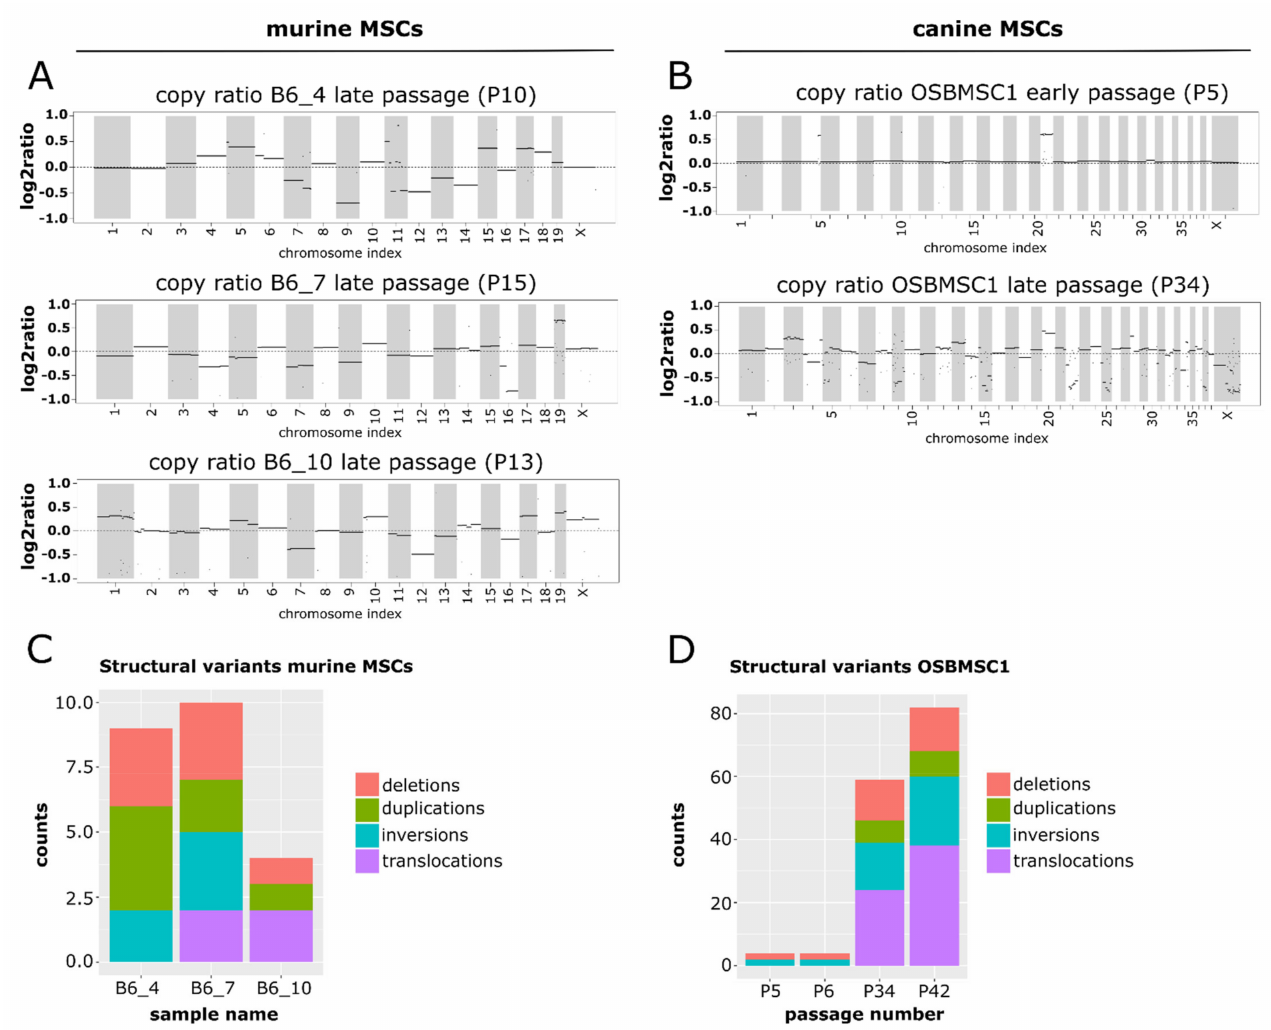
Figure 5. Late passage murine and canine MSCs show a complex molecular karyotype after whole-genome sequencing. Segmented copy ratios are shown for ( A ) late passage murine MSCs and ( B ) early and late passage canine MSCs. Positive copy ratios indicate a gain of genomic materials, whereas negative ratios indicate losses. The total number of structural variants in ( C ) late passage murine MSCs and ( D ) early and late passage canine